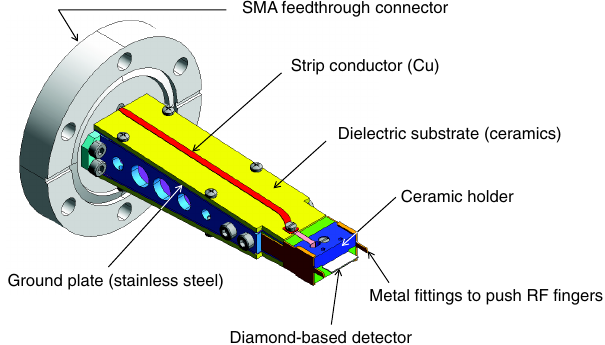
FIG. 13. Microstripline structure with SMA feedthrough con- nectors on an ICF70 flange. The diamond-based detector is clamped on a ceramic holder.